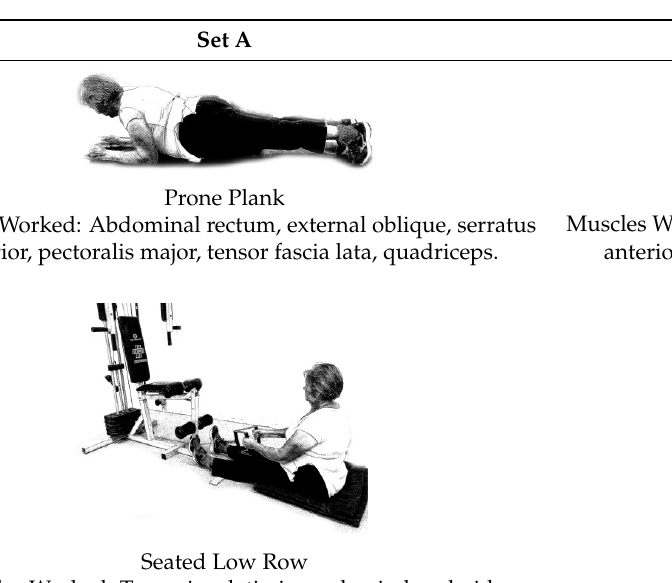
Table 1. Strength training regimens.